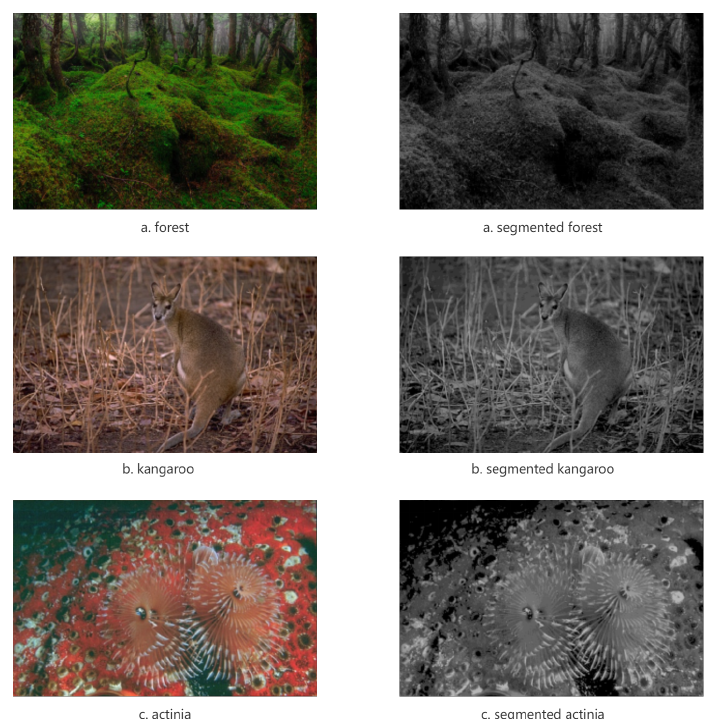
Figure 3. Group1: Original Images and Segmented Images on D = 10.